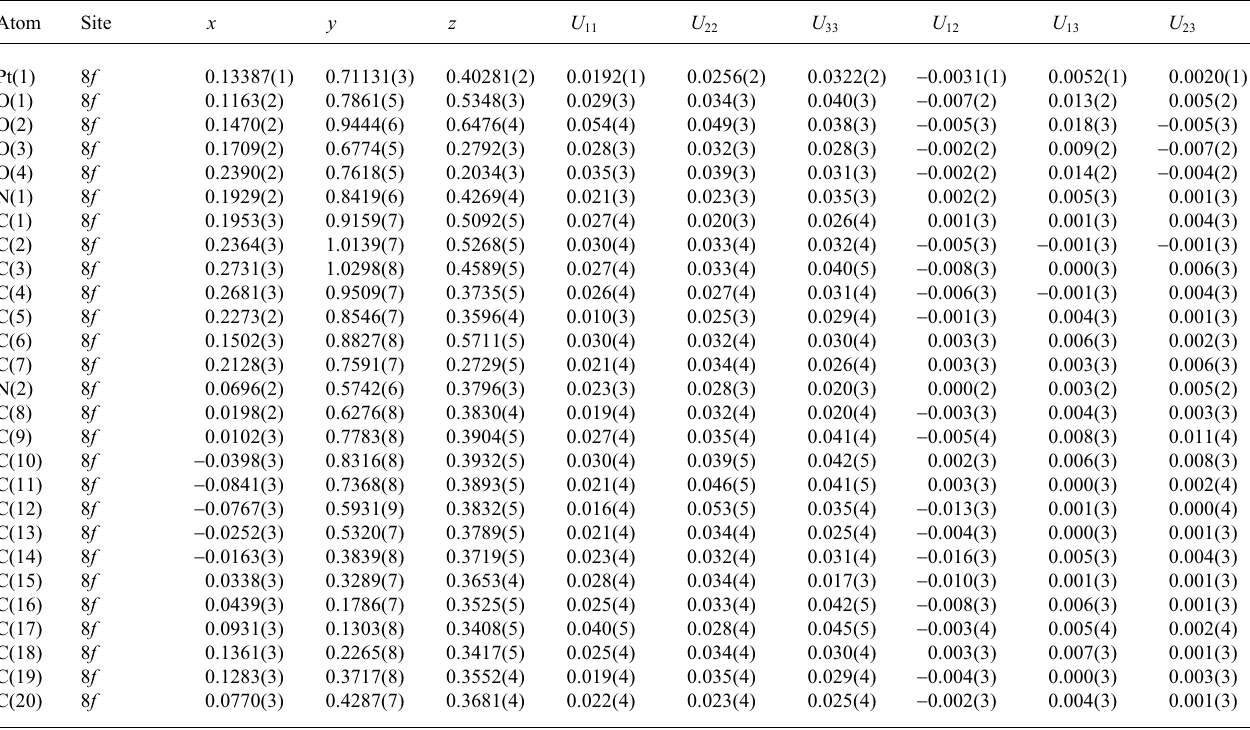
Table 3. Atomic coordinates and displacement parameters (in Å 2